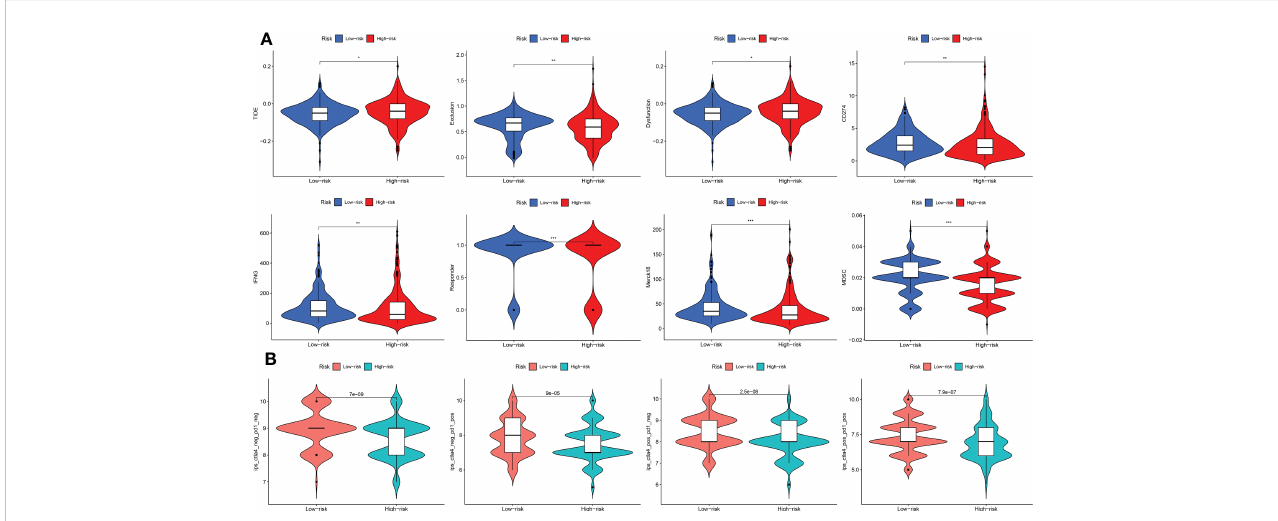
FIGURE 8 Immunotherapy response of low- and high-risk THCA. (A) Difference of the TIDE, Exclusion, Dysfunction, CD274, IFNG, Responder, Merck18, and MDSC score between low- and high-risk THCA. (B) IPS score of the low- and high-risk THCA in the of CTLA4- PD1-, CTLA4- PD1+, CTLA+ PD1-, and CTLA+ PD1+ subgroups. * indicated P<0.05; ** indicated P<0.01; *** indicated